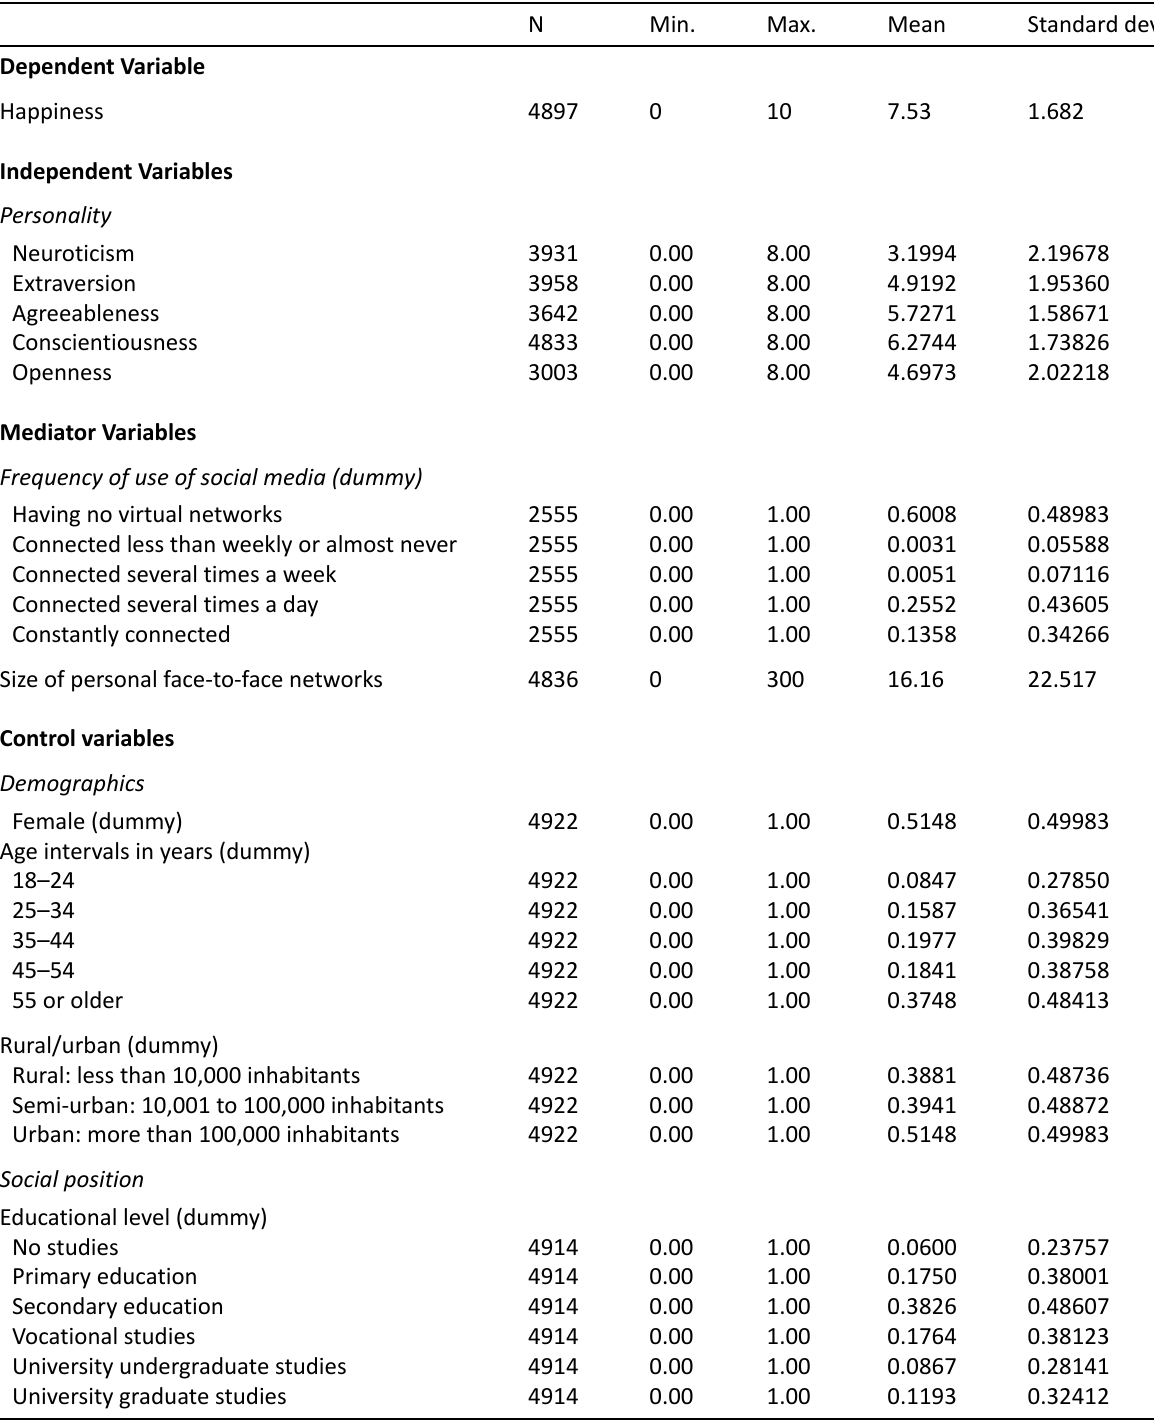
Table 2. Descriptive statistics of the variables in the regression